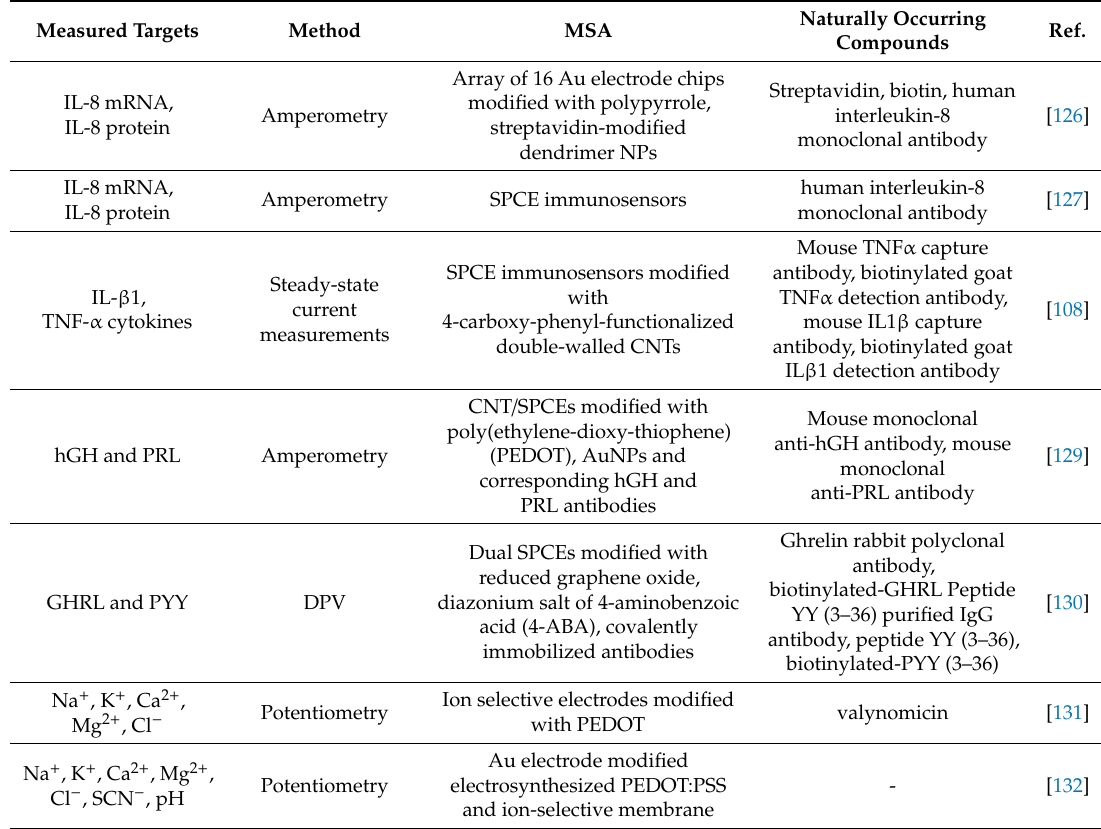
Table 3. Summary of MSS / MSA application for analysis of